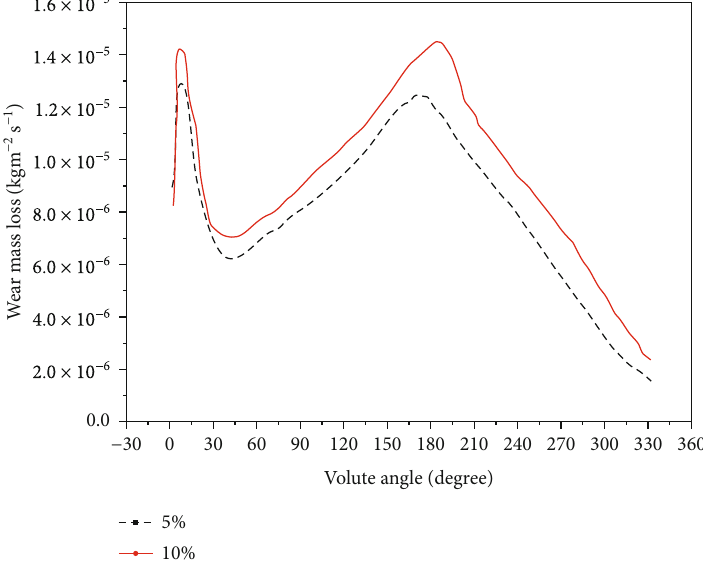
Figure 7: Variation in wear along the outer casing wall at two solid concentrations for the solid-liquid mixture at 15m 3 /h discharge